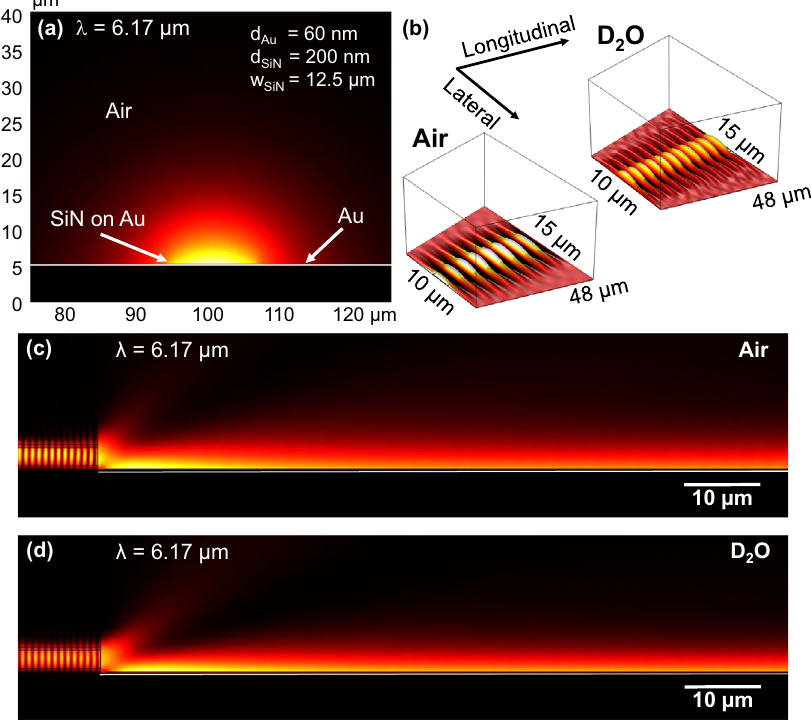
Fig.2|FEM-basedsimulationsat1620cm − 1 (=6.17 μ m).a Themodecross-section of the SiN on Au DLSPP waveguide ( n SiN =1.79, dimensions in inset: d Au : gold thickness, d SiN : SiN thickness and w SiN : width SiN slab), b 2D topview simulation along the tapered 48 μ m DLSPP waveguide between QCL and QCD in air (left) and